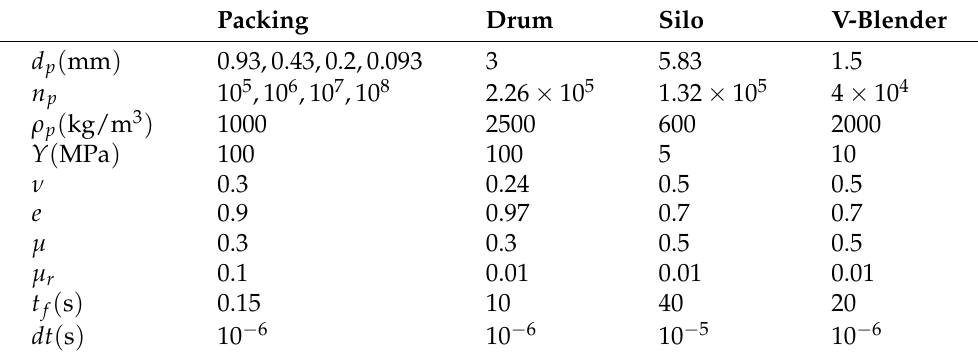
Table 1. Simulation and physical properties of the packing in rectangular box, rotating drum, silo and V-blender simulations.